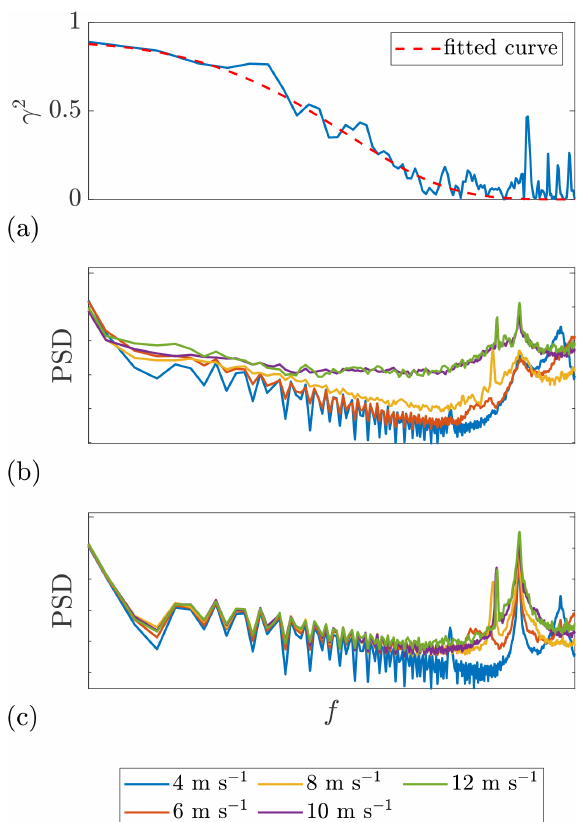
Figure A2. (a) Example coherence: U l = 11 . 7ms − 1 , d = 81 . 75m, R 2 = 0 . 95. (b) and (c) PSDs of the fore-aft and in-plane tower top acceleration, respectively. The x axis is logarithmic. Date and time: 7 December 2013 at 12:00–12:30. Data source: Lidar Complex. Be- cause of data protection it is not allowed to show any values con- cerning the turbine